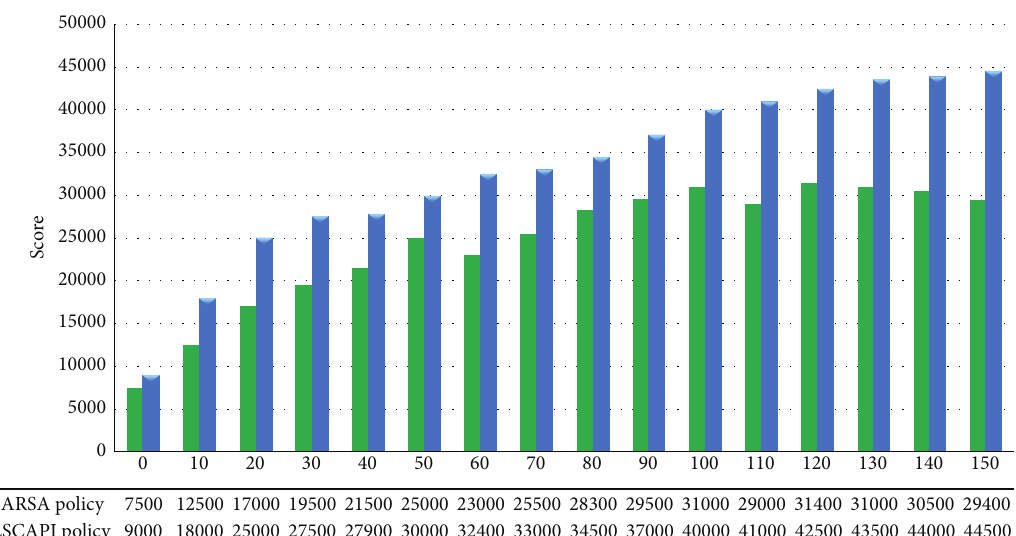
Figure 17: SARSA versus LSCAPI policy scores during Terran scenario